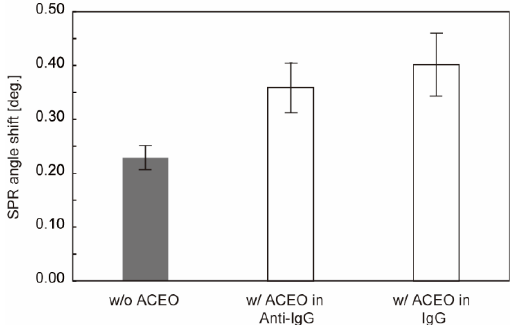
Figure 6. Comparison of SPR angle shift of analyte binding. w/o ACEO indicates the signal obtained from a conventional sensor chip without applying voltage. w/ACEO in Anti-IgG and w/ ACEO in IgG indicate the signals obtained by the application of voltage in antibody-immobilization and analyte-binding steps, respectively (N = 4). Error bars show the standard deviation.